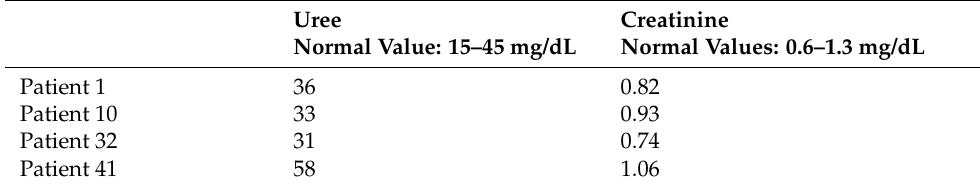
Table 12. Urea dosage levels for AL patients.